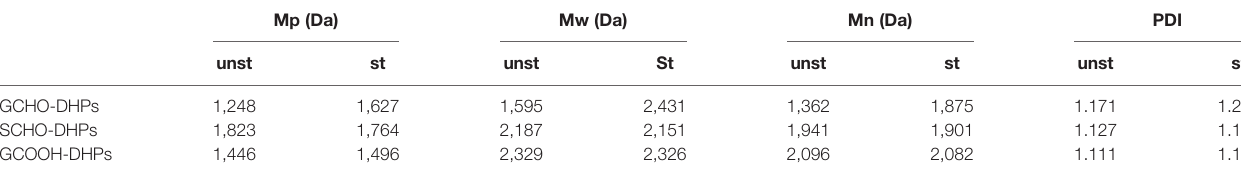
TABLE 1 | Polymer characterization of C 6 C 3 G aldehyde, acid, and S aldehyde DHPs determined by gel-permeation chromatography (GPC). Mp (Da) Mw (Da) Mn (Da) PDI unst st unst St unst st unst st